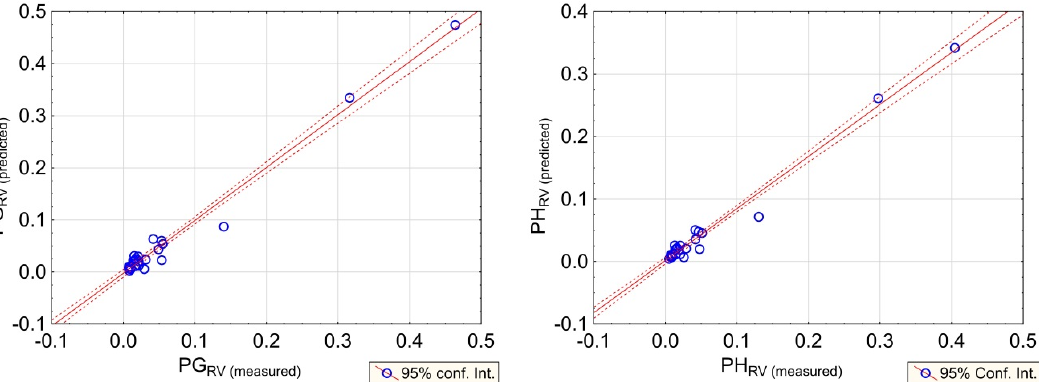
Figure 15. Regression plots for predicted vs. observed values of PG RV - left , and PH RV - right , at the Zelazny Most tailing pond.